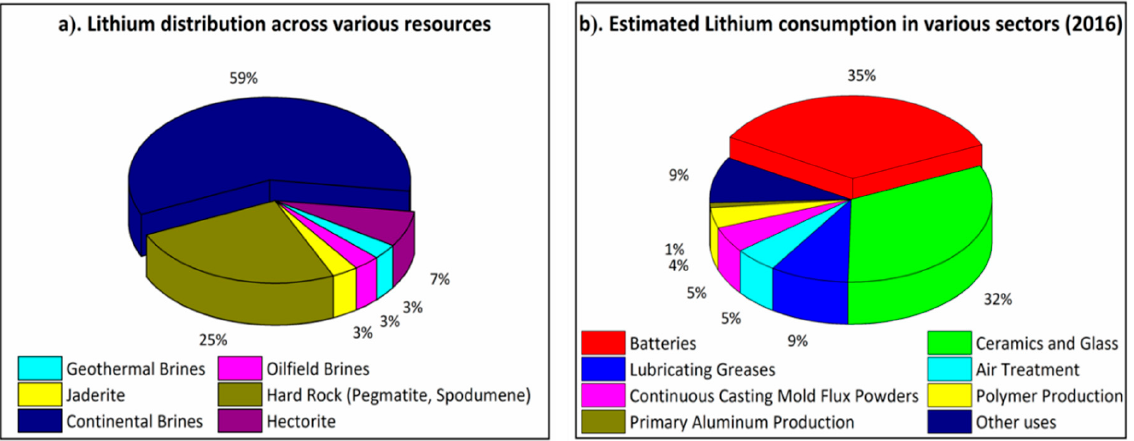
Figure 2. ( a ) Lithium distribution based upon primary lithium resources and ( b ) distribution of global lithium consumption for various applications.